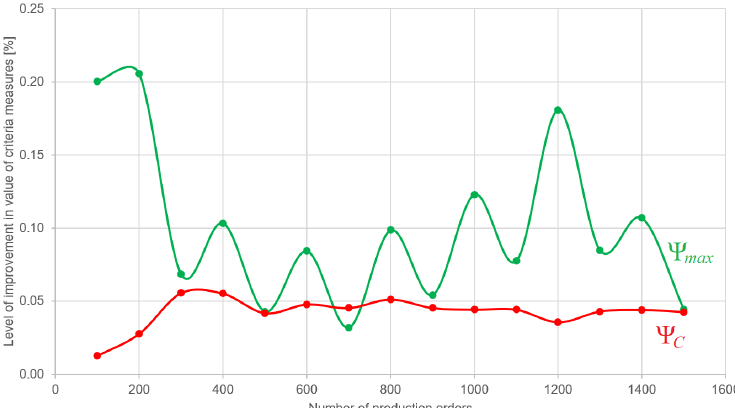
Figure 11. The effect of taking into account the influence of resources for the production of self- adhesive PVC